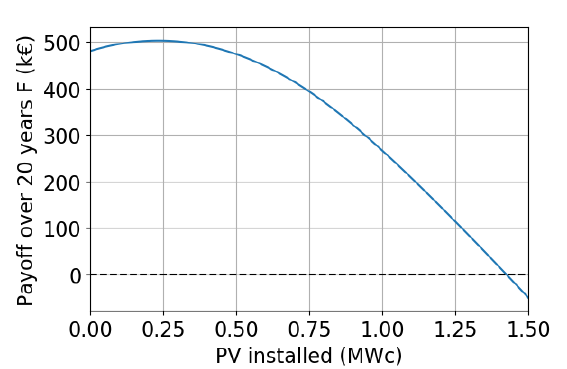
Figure 10. Payoff F over 20 years (with λ cst = λ ∗ cst ) in function of the PV nominal power. The CPO can make more profits by installing (the right amount of)